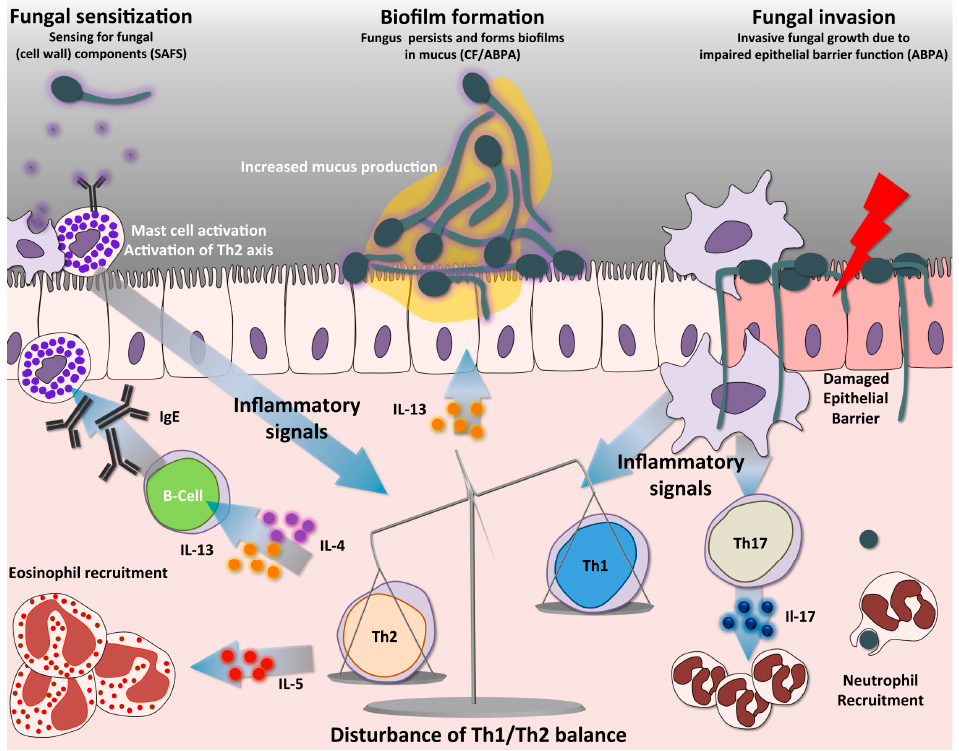
Figure 2. Immune pathways in SAFS and ABPA. Antigen presentation by DCs activates naïve